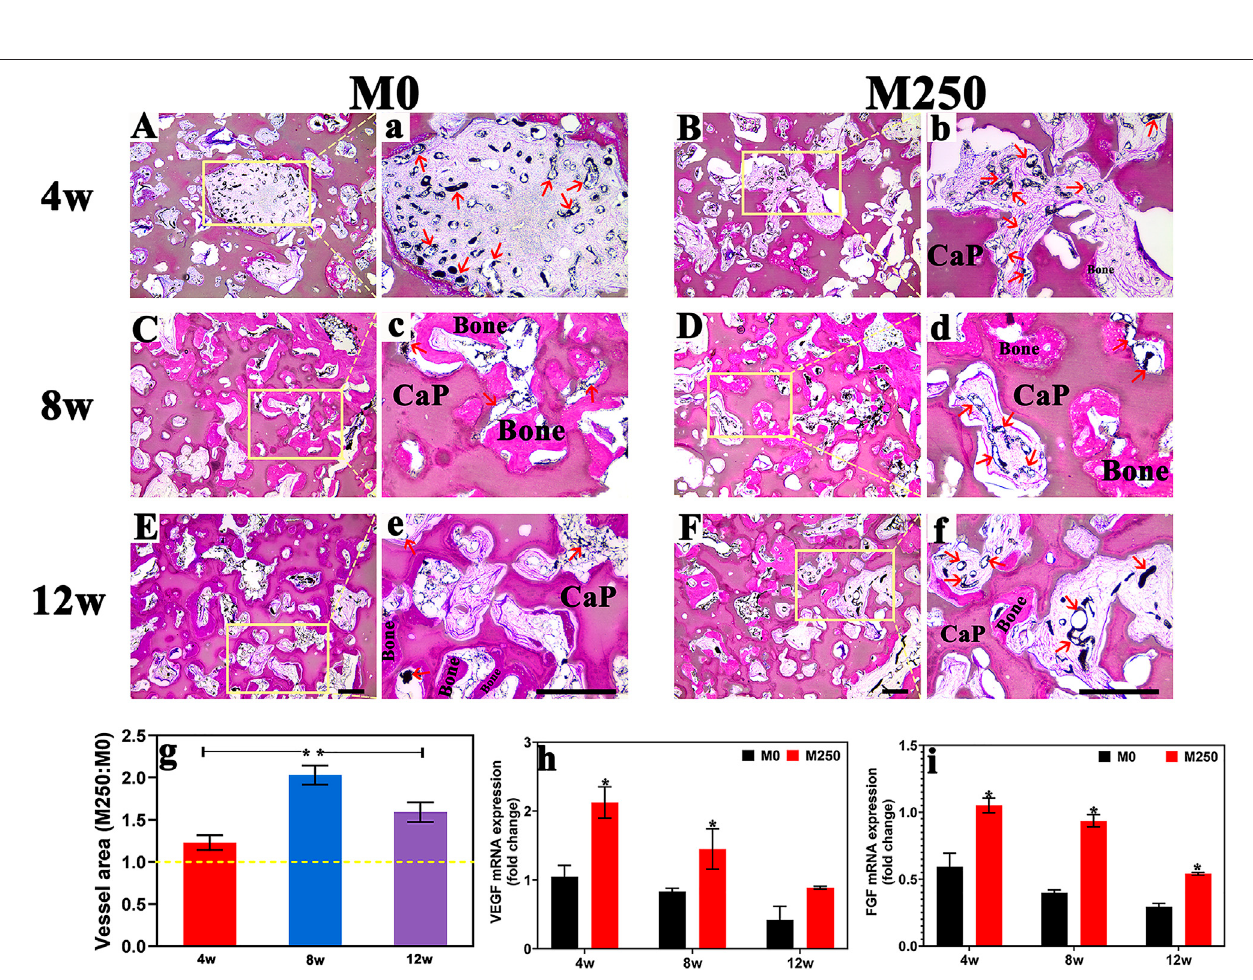
Frontiers in Materials |